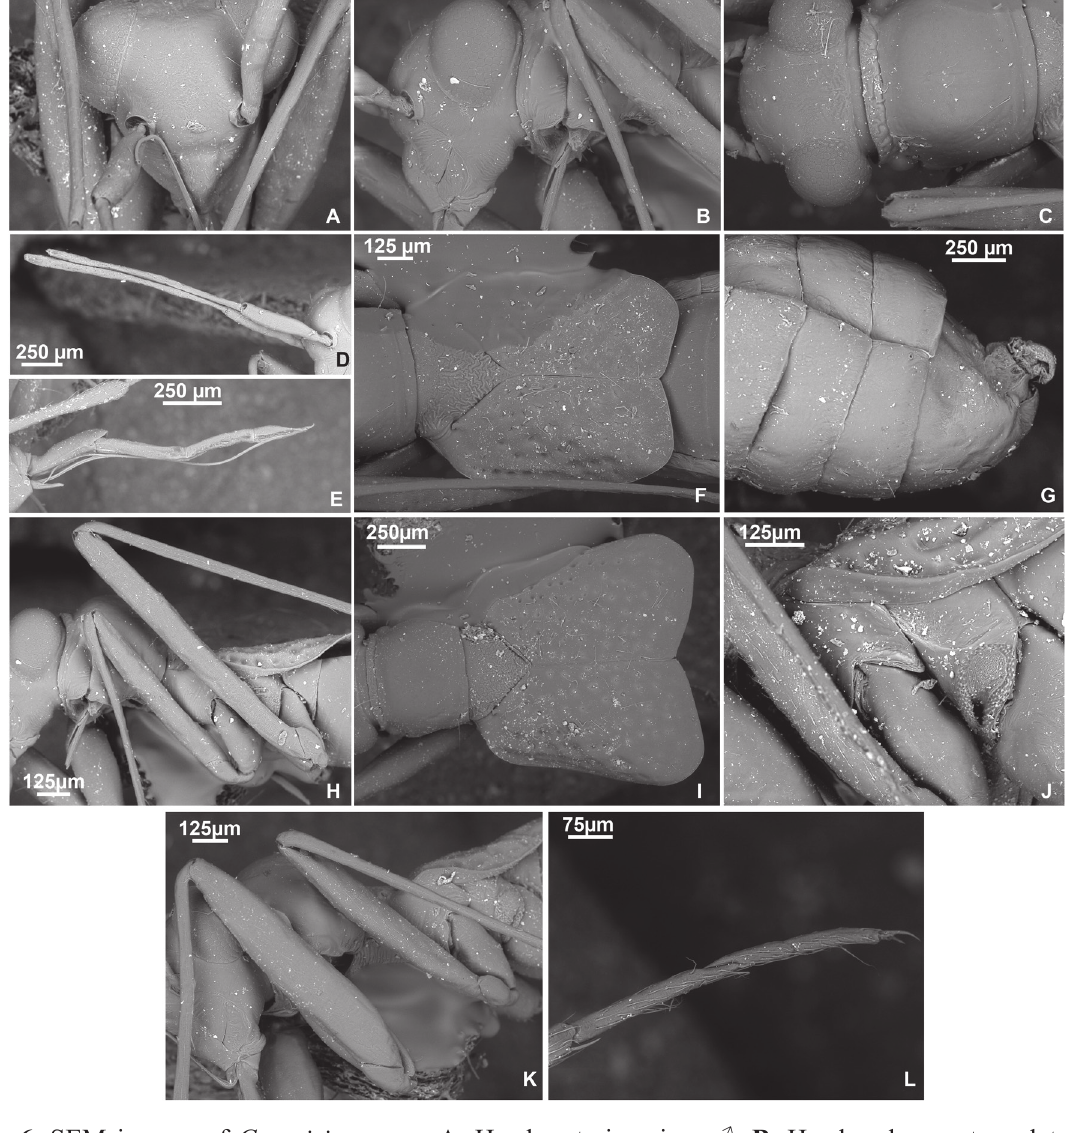
Fig. 6. SEM images of C. weiri sp. nov. A . Head, anterior view, ♂. B . Head and pronotum, lateral view, ♂. C . Head and pronotum, dorsal view, ♂. D . Antennal segments I and II, ♂. E . Labium, ♀. F . Hemelytron, ♂. G . Abdomen, lateral view, ♂. H . Middle and hind femora, ♂. I . Hemelytron, ♀. J . Pleura, ♀. K . Fore- and middle femora, ♂. L . Hind tarsus,